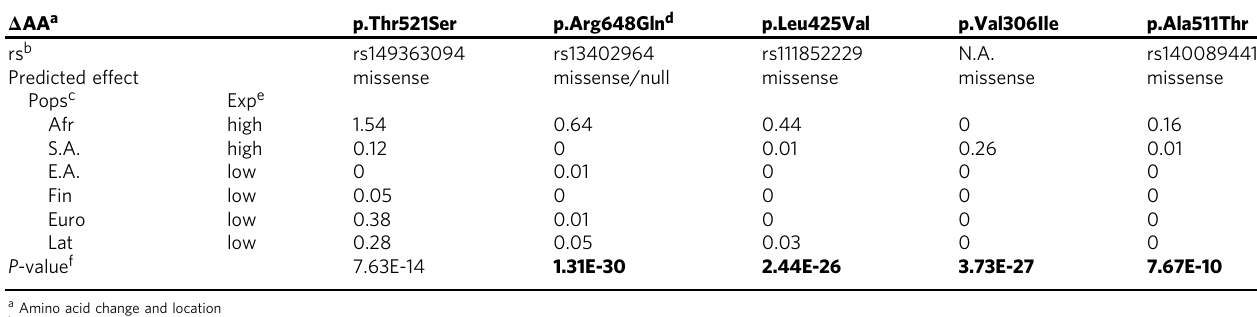
Table 2 The fi ve most prevalent ABCB6 coding variants enriched in high malaria exposure populations as percent of population, from the ExAC database Δ AA